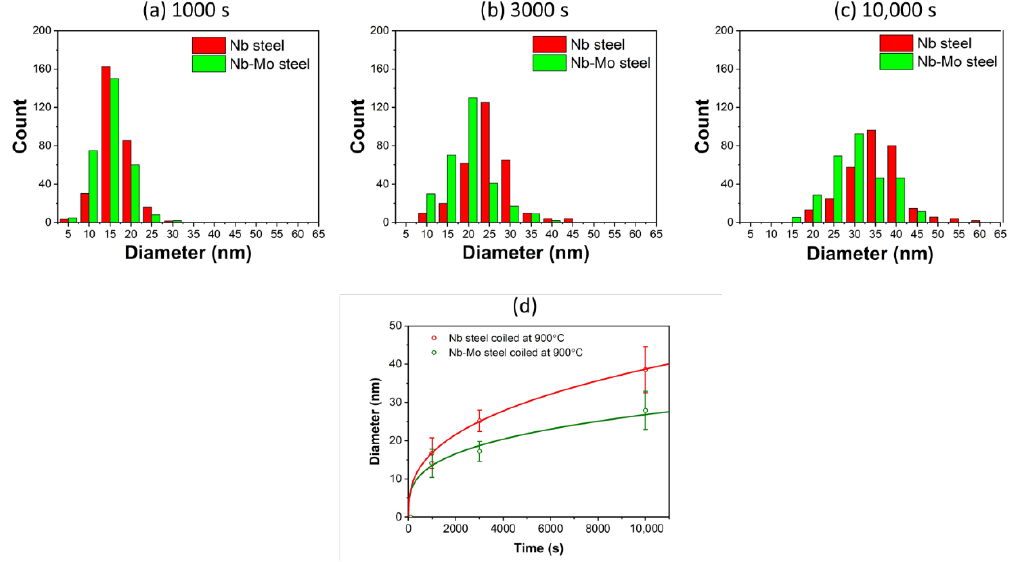
Figure 5. Size distributions ( a – c ) of the carbides in the Nb and Nb-Mo steels heat treated at 900 °C for 1000 s, 3000 s, and 10,000 s, respectively. ( d ) is the average particle size evolution of the two steels during isothermal holding at 900 °C.